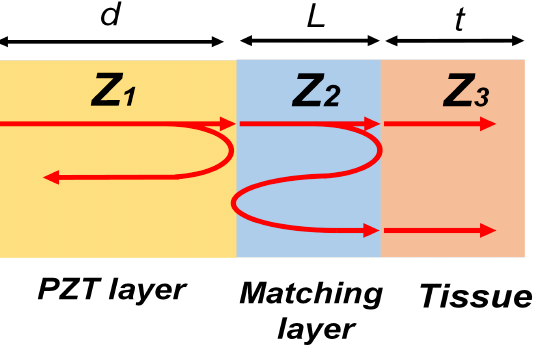
Figure 1. A schematic representation of wave transmission and reflection in the matching